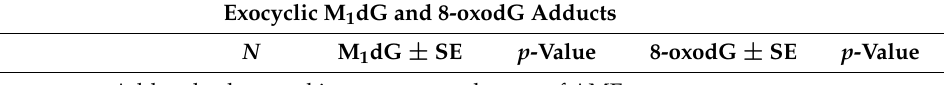
Table 2. Mean levels of 3-(2-deoxy- β - D -erythro-pentafuranosyl)pyrimido[1,2- α ]purin-10(3 H